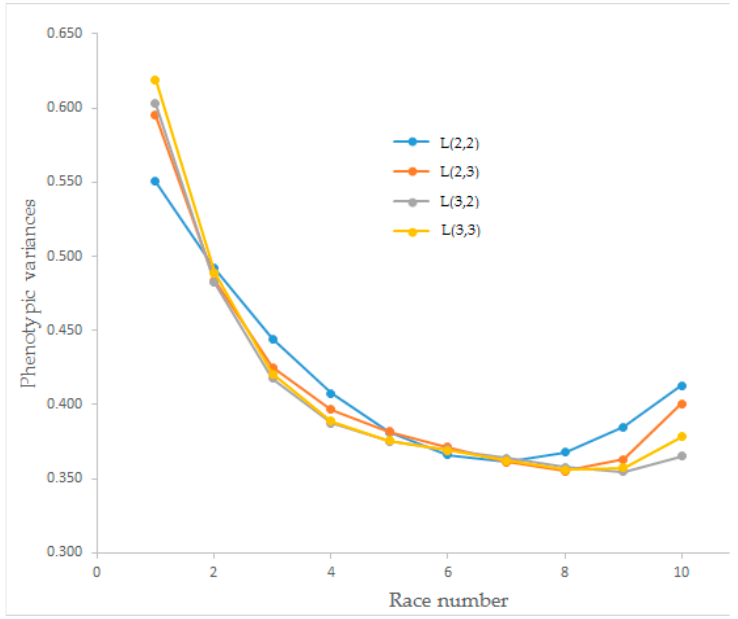
Figure 3. Estimation of the phenotypic variances for race speed from different orders of Legendre polynomial models.